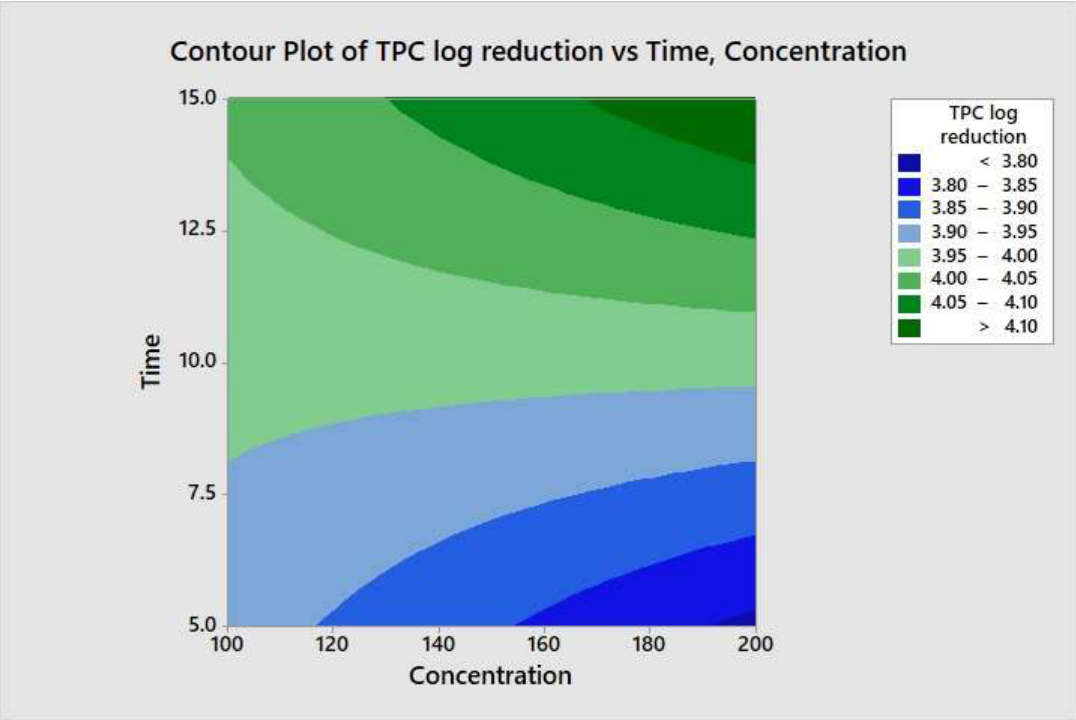
Molecules 2021 , 26 , x FOR PEER REVIEW Figure 8. Contour plot of the total aerobic mesophilic bacteria logs reduction versus time and concentration.